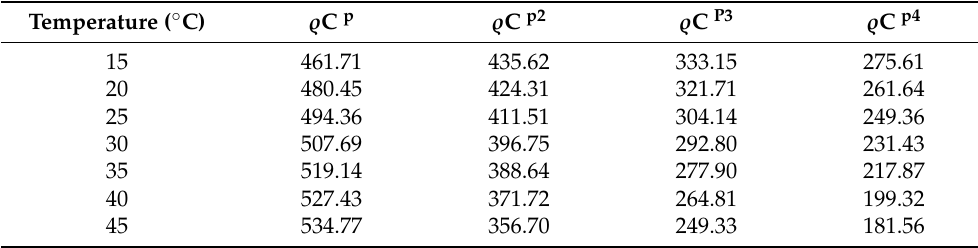
Table 2. Variation of specific heat (J/K/mol) of nanofluid ( nf ) with temperature ( ◦ C) and amount of solvents.